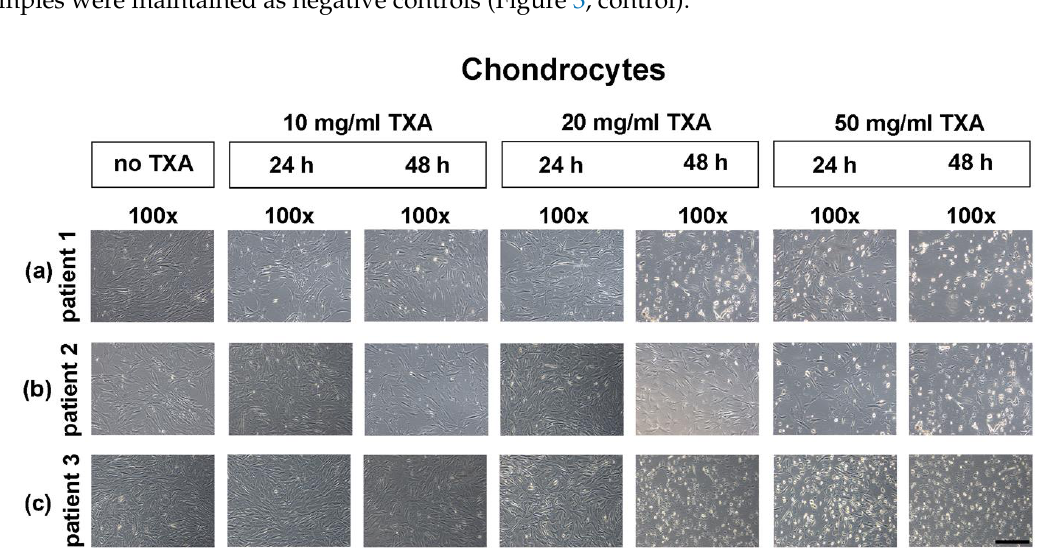
Figure 3. Microscopical analysis of chondrocyte growth in monolayer cultures after treatment with different concentrations of tranexamic acid for varying exposure times. Chondrocytes were harvested from the hyaline hip cartilage of three separate patients that underwent total hip arthroplasty. Cells were seeded in cell culture flasks, incubated in cell culture medium and grown to confluency. After reaching confluency, controls were maintained (no TXA), while other cells were exposed to 10 mg/mL, 20 mg/mL or 50 mg/mL of TXA. The exposure time varied from 24 h to 48 h. Representative samples from three different donors were captured directly after treatment with TXA at low (100x; black bar = 200 μm) magnification. TXA, tranexamic acid; min, minutes; d, days; h, hours.